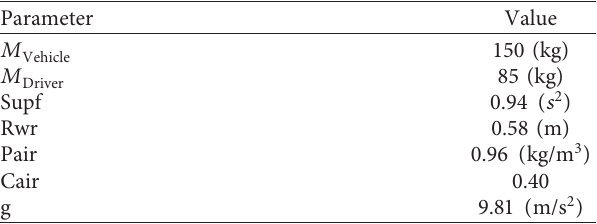
Table 1: Vehicle and environment characteristics.